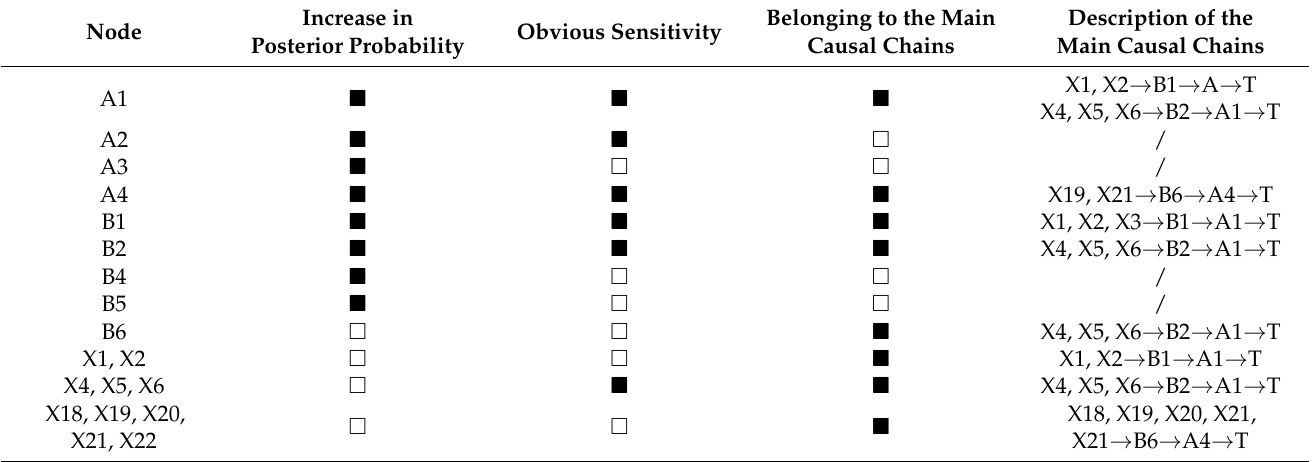
Table 6. Key factors contributing to the BFG leakage